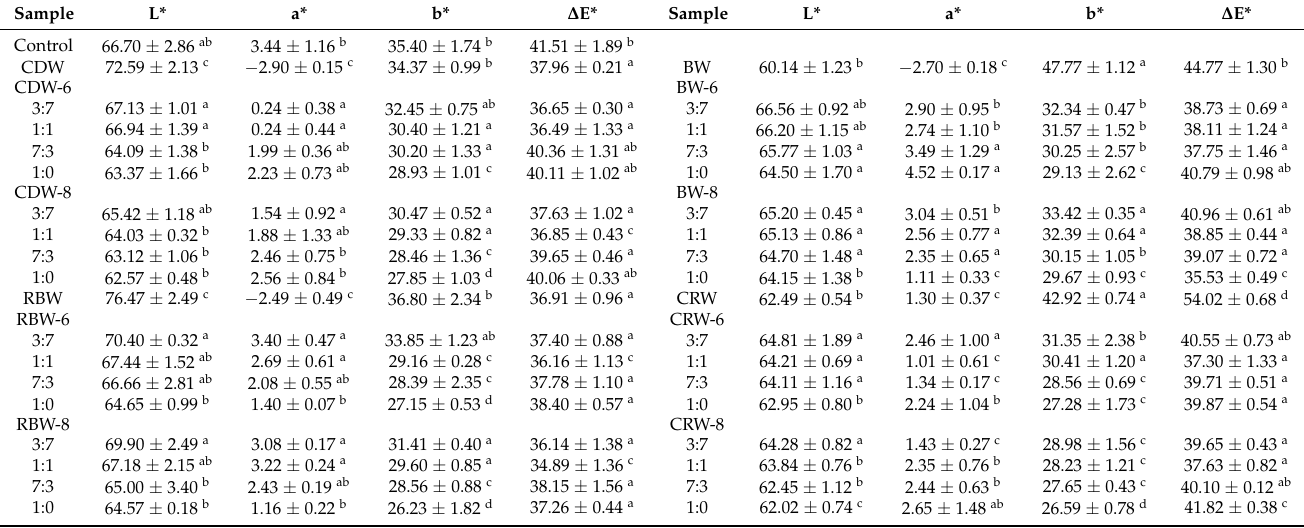
Table 1. The color parameters of cookies prepared using CDW, BW, RBW, and CRW oleogels at 6 wt.% and 8 wt.% in different proportions of shortening replacement (25 ◦ C). a,b,c,d represents the significant difference in color of different